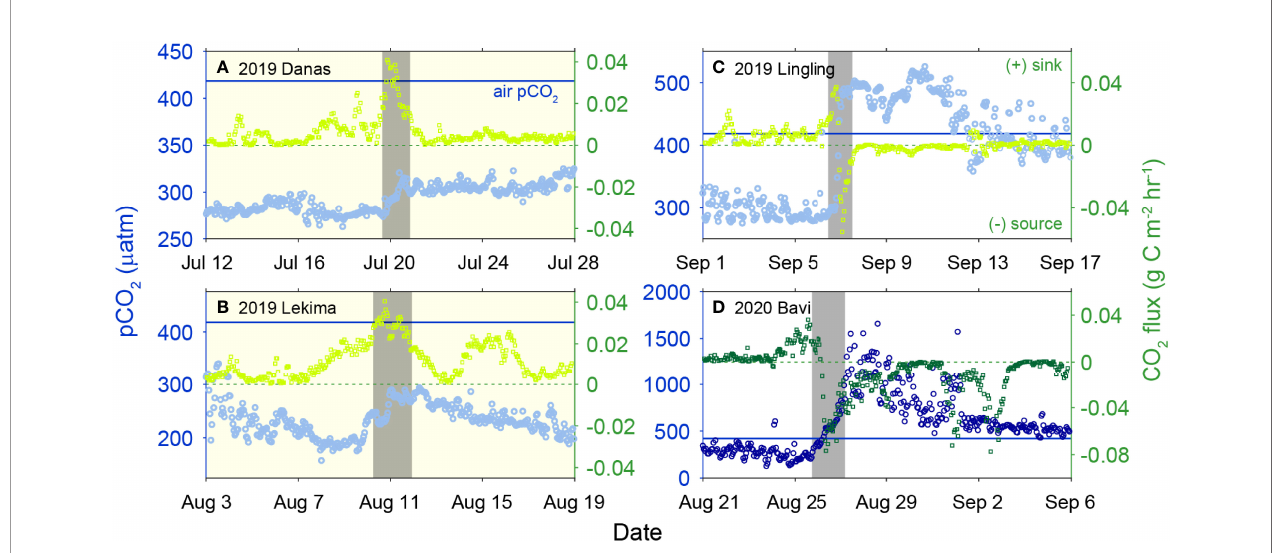
FIGURE 5 | Changes in seawater pCO 2 (left y -axis) and air – sea CO 2 fl ux (right y -axis; positive and negative values represent fl uxes of C from atmosphere to ocean and from ocean to atmosphere, respectively) near the landing period of typhoons: (A) Danas (2019), (B) Lekima (2019), (C) Lingling (2019), and (D) Bavi (2020). Vertical shades (in black) represent the period of the typhoon landfall. Solid horizontal lines (in blue) indicate the level of mean pCO 2 of the air (419 µatm).